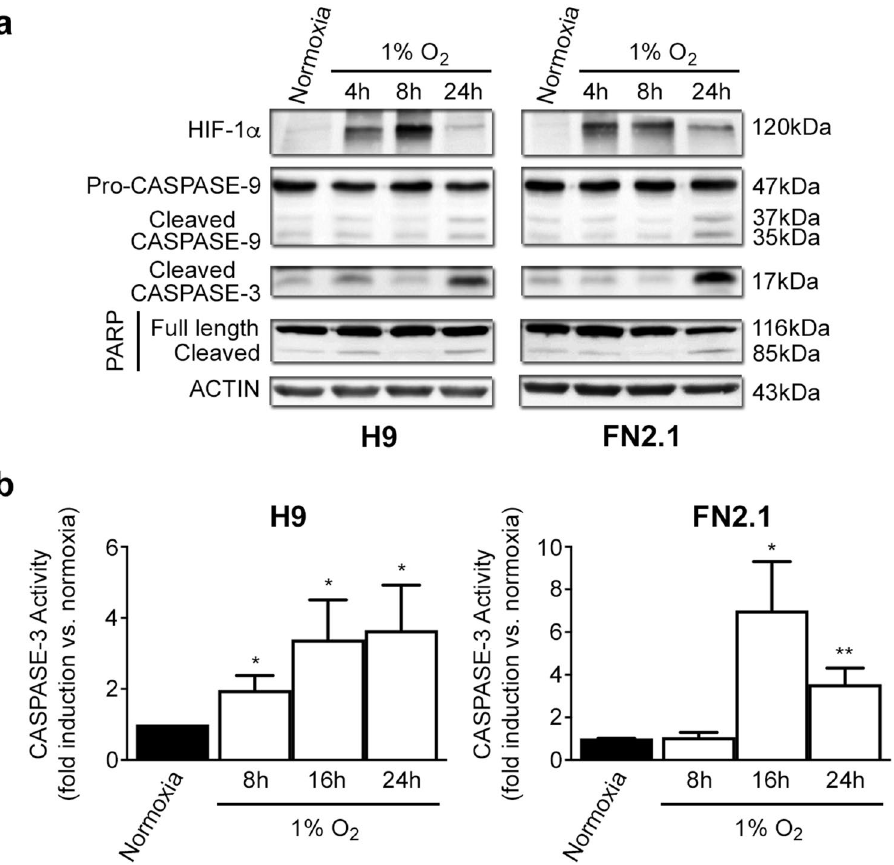
Figure 3. CASPASE-9, CASPASE-3 activation, and PARP cleavage upon 1% O 2 hypoxia induction. ( a ) Cleavage and activation of initiator CASPASE-9, effector CASPASE-3, PARP proteolysis (CASPASE-3 substrate), and HIF-1α stabilization were analyzed by western blot in H9 hESCs and FN2.1 hiPSCs at 4-, 8- and 24-h post 1%